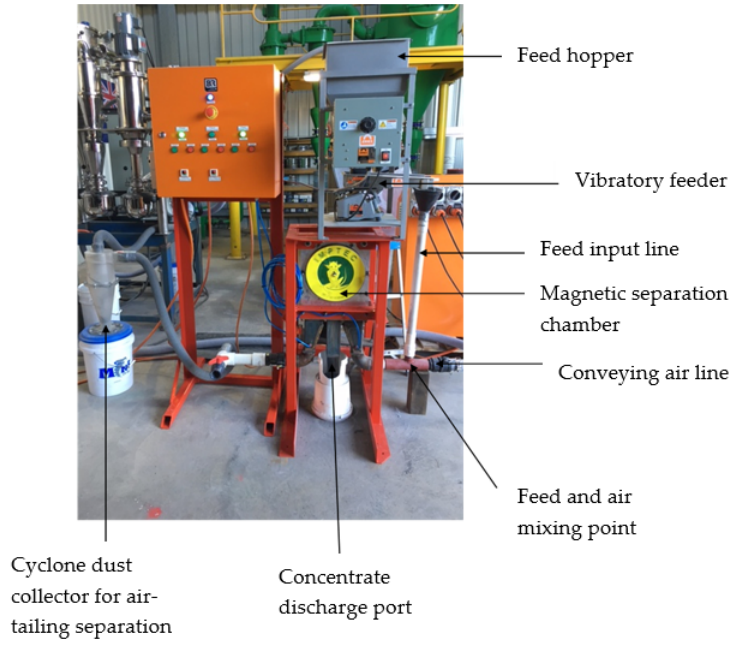
Figure 2. PMS experimental setup.